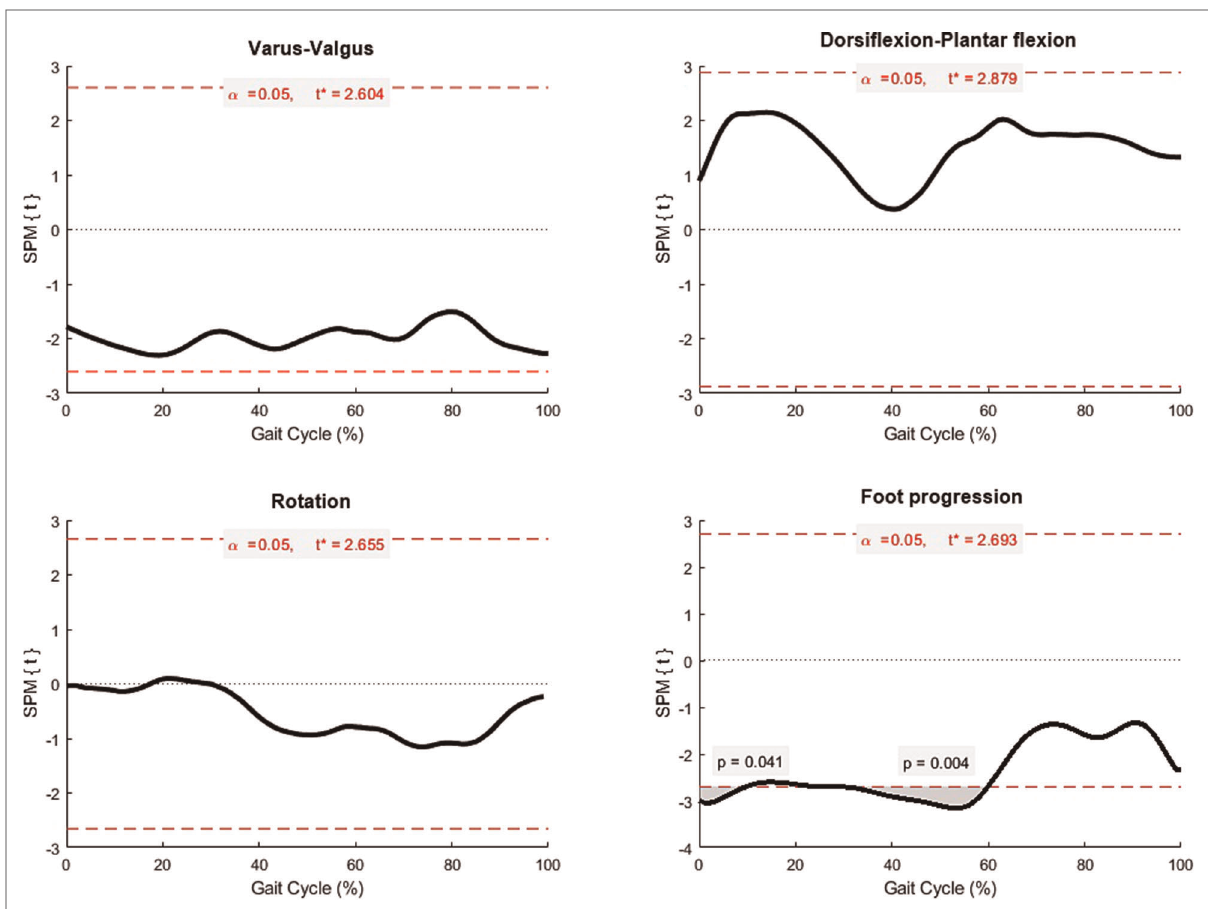
FIGURE 2 Statistical parametric mapping (SPM) comparing ankle kinematics between sides (black line), and grey area represented signi fi cant difference at points of time with P <0.05.